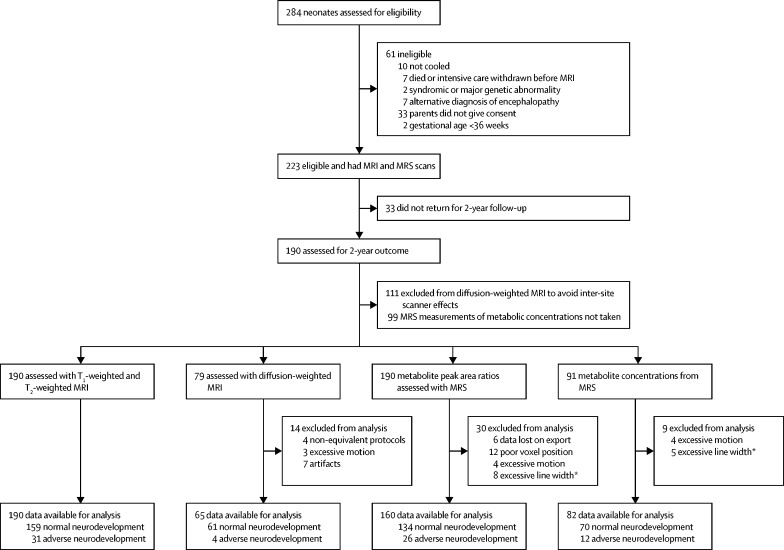
Study profileMRS=magnetic resonance spectroscopy. *Excessive line width defined as greater than mean + 2SD.